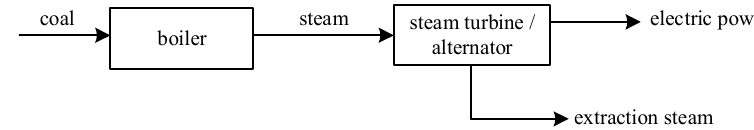
Figure 5. Mechanism of the extraction condensing unit.